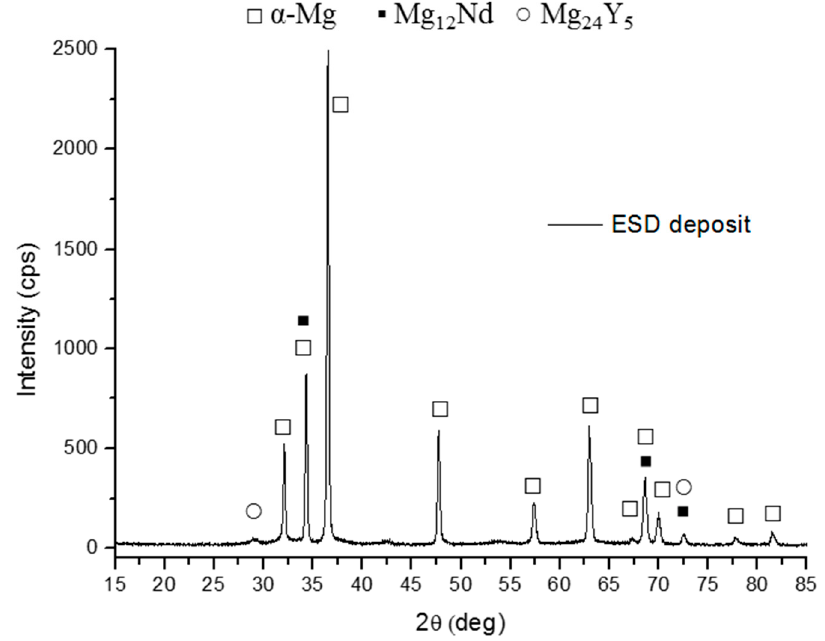
Figure 6. XRD pattern of WE43 magnesium alloy deposit.